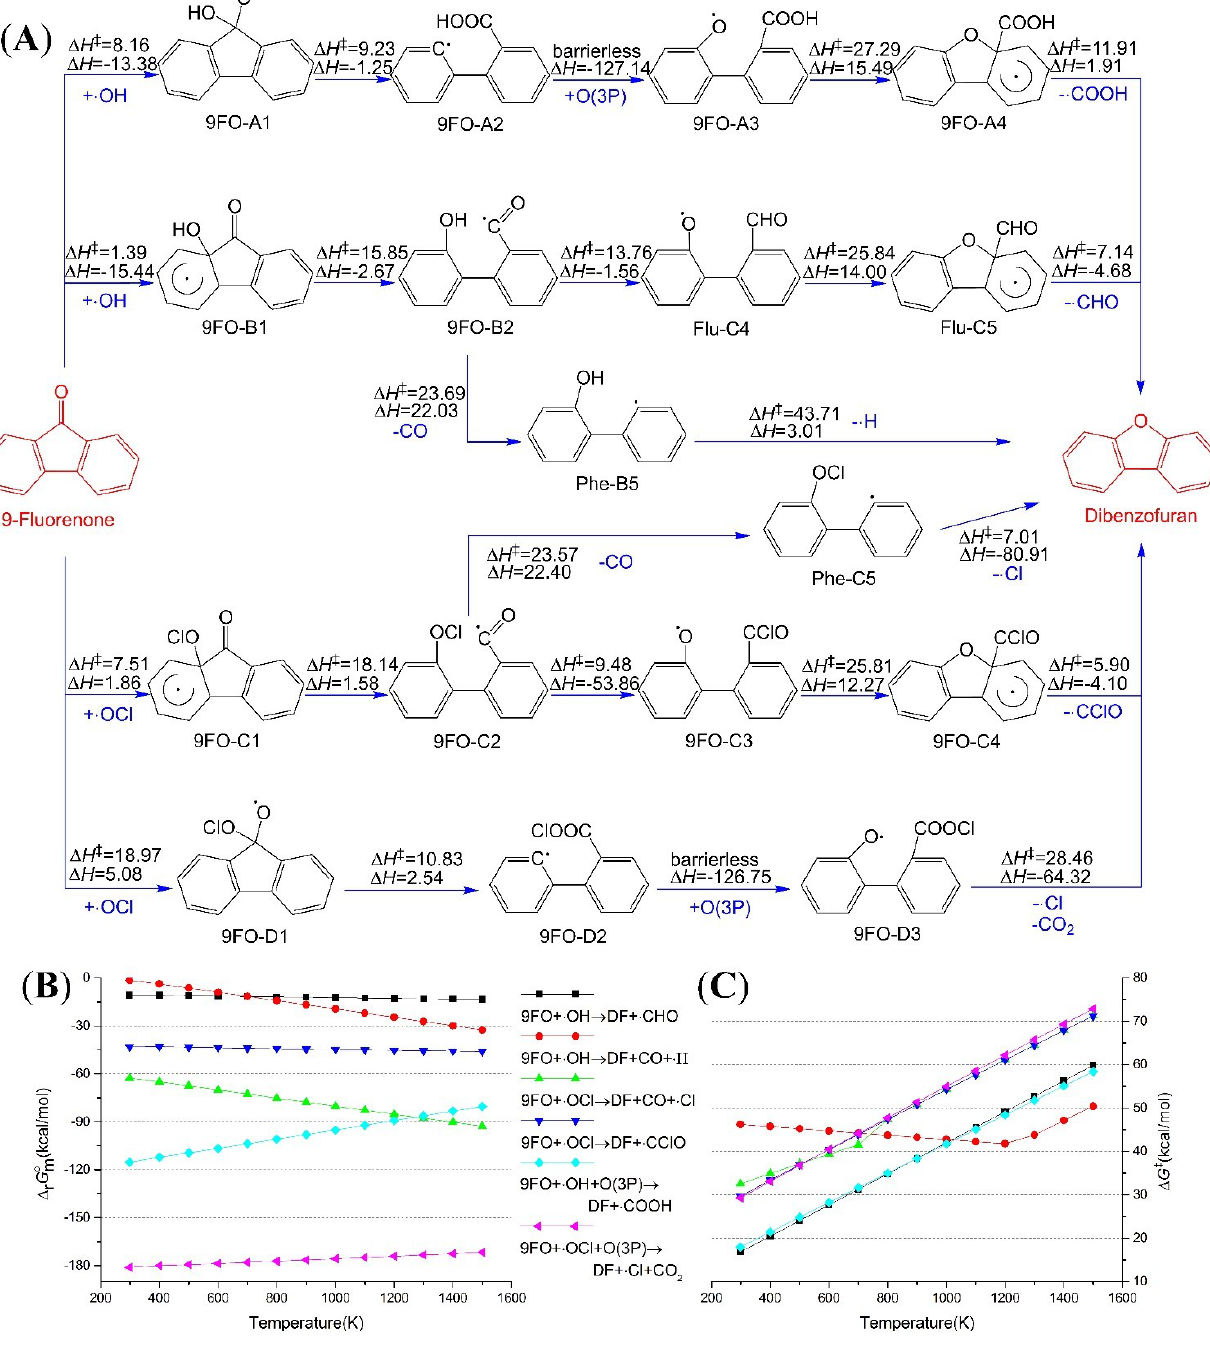
Figure 3. Dibenzofuran formation paths from 9-fluorenone (9FO); ( A ) Reaction scheme, enthalpies were calculated at 1000 K, and energy unit is kcal/mol; ( B ) Standard Gibbs energy changes for the overall reactions; ( C ) Activation Gibbs energies for the overall